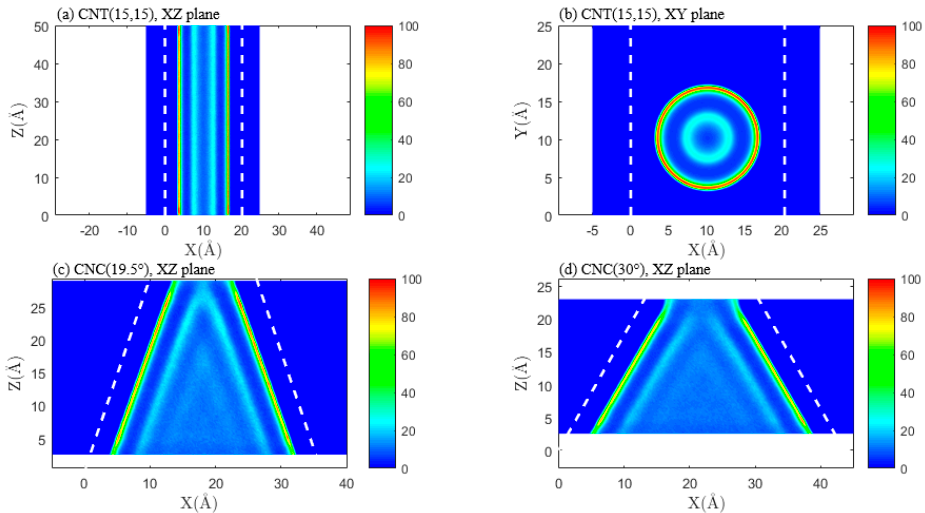
Figure 4. CH 4 density distribution in CNT/CNC: ( a ) CNT (15,15), XZ plane; ( b ) CNT (15,15), XY plane; ( c ) CNC (19.5°), XZ plane; ( d ) CNC (30°), XZ plane. T = 338 K, P = 30 MPa.